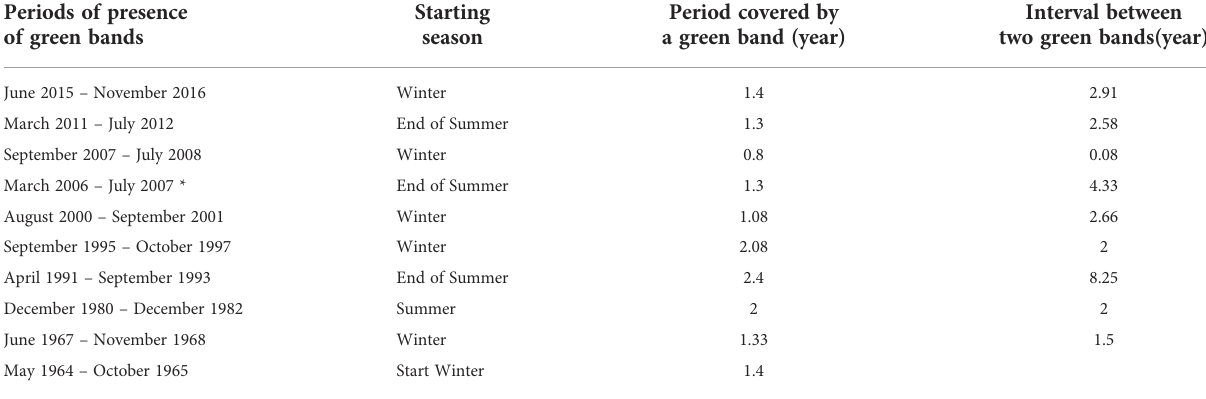
* : Two green bands with only one month interval. They were considered as one green